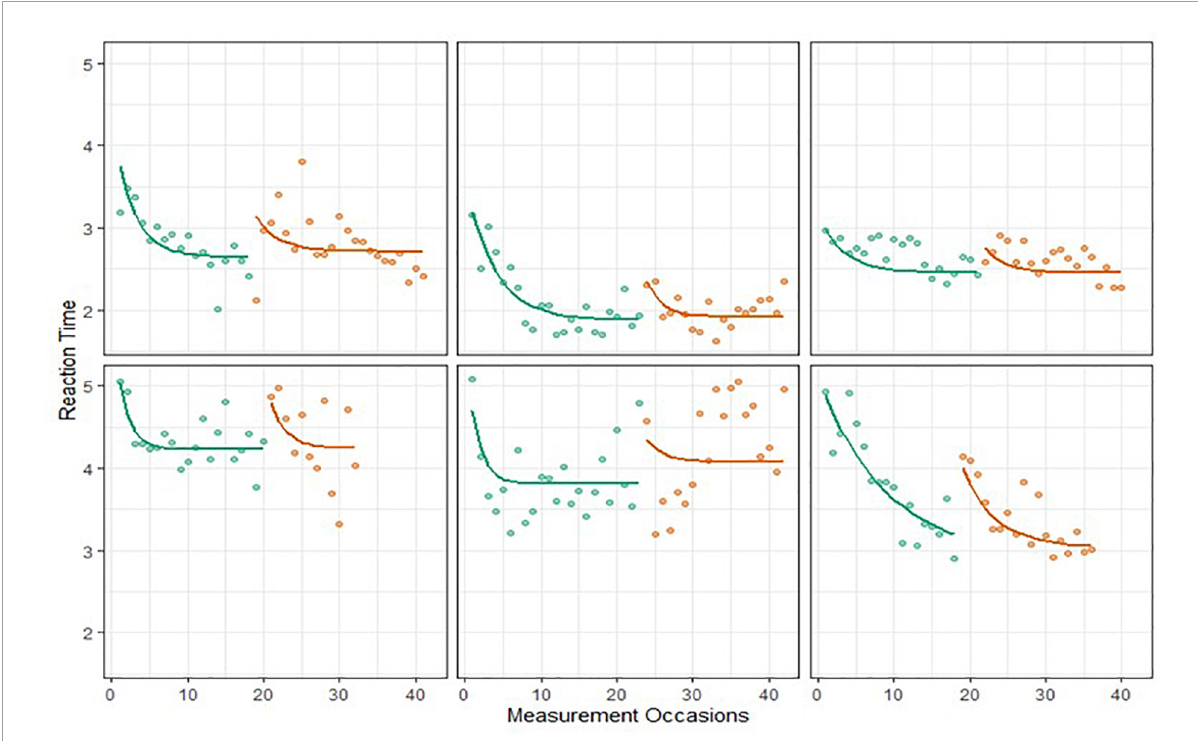
FIGURE6 Six Einstein Aging Study (EAS) participants’ symbol search data and predicted BDEM